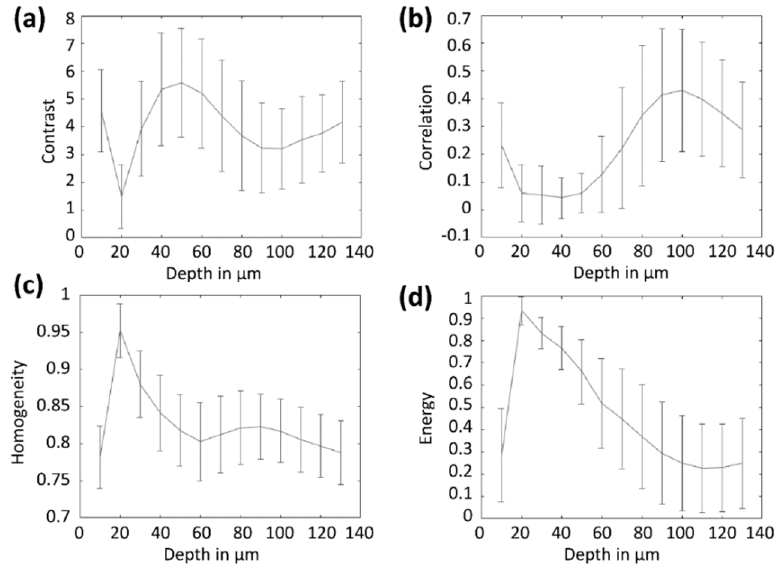
Figure 2. Depth analysis of statistical GLCM properties. GLCM parameters contrast ( a ), correlation ( b ), homogeneity ( c ), and energy ( d ) were recorded from the stratum corneum to a 130 µm depth on the volar forearm in 24 volunteers. The data are presented as a line plot with straight lines connecting the mean data points.